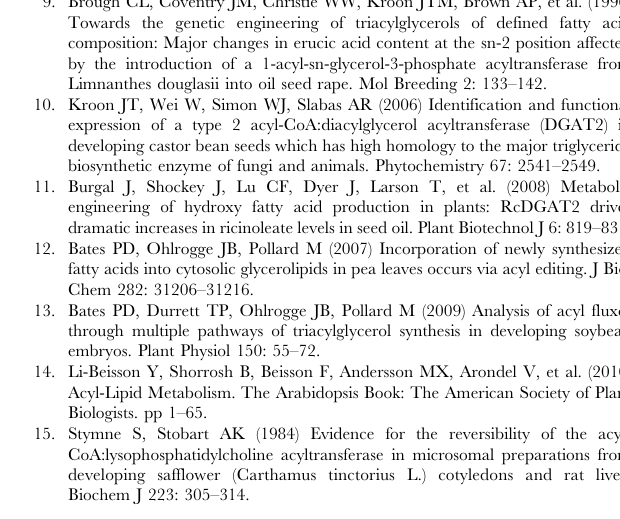
Figure S2 Heatmap of selected lipid metabolism and storage protein genes differentially expressed in five castor tissue samples. Table S1 Summary of sequence read mapping. Table S2 Expression values of castor gene models and significant differences between castor tissues. Table S3 Read counts of candidate genes for fatty acid, glycerolipid and wax metabolism and for storage proteins. Table S4 Genes in the heatmap made from lipid synthetic and storage proteins that are co-expressed with oleate hydroxylase in Ricinus tissues. Table S5 Expression of lipid metabolic genes in castor germinating seeds, developing endosperm and male flowers. Table S6 Castor genes with the highest FPKM values in the five castor tissues. Table S7 Castor gene models ordered on FPKM values in individual tissues. Table S8 Lipid metabolism genes with proven roles in male gametophyte and floral development. Table S9 Expression of castor transcription